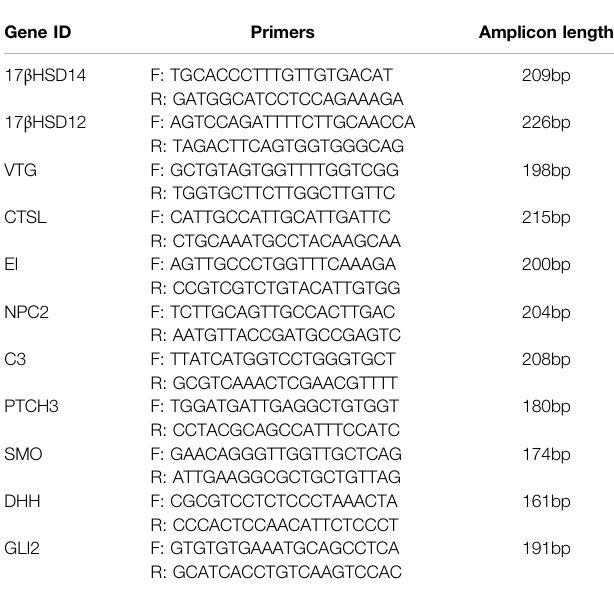
TABLE 3 | Genes of Interest and their corresponding primers used in qPCR reaction. Annealing temperature for all primers was 60 ° C.